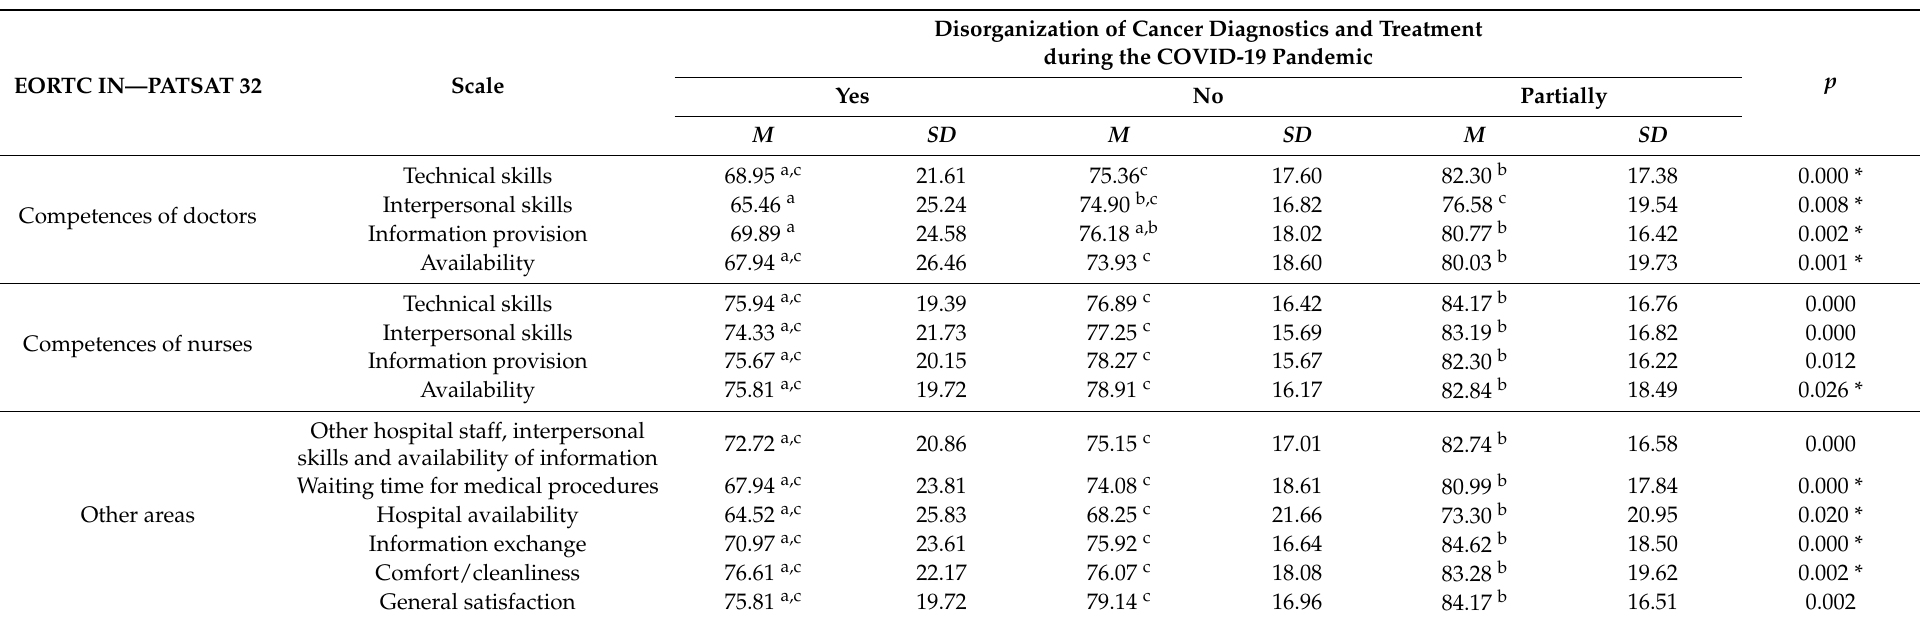
Disorganization of Cancer Diagnostics and Treatment during the COVID-19 Pandemic